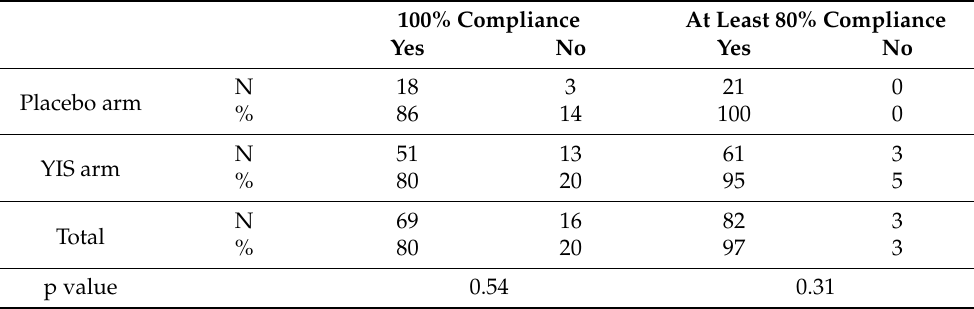
Table 4. Compliance to syrup consumption as calculated from volumes of syrup in returned syrup